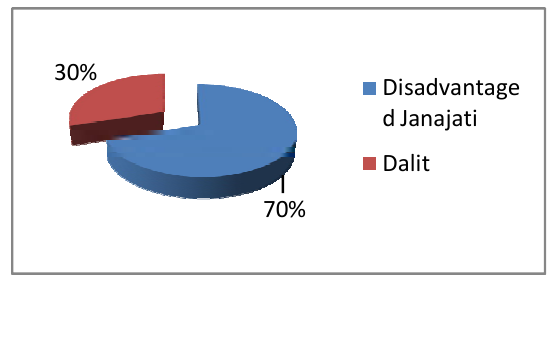
Fig. 1: Distribution of Cast/Ethnicity among under five children Table 2: Personal Hygiene of the Children